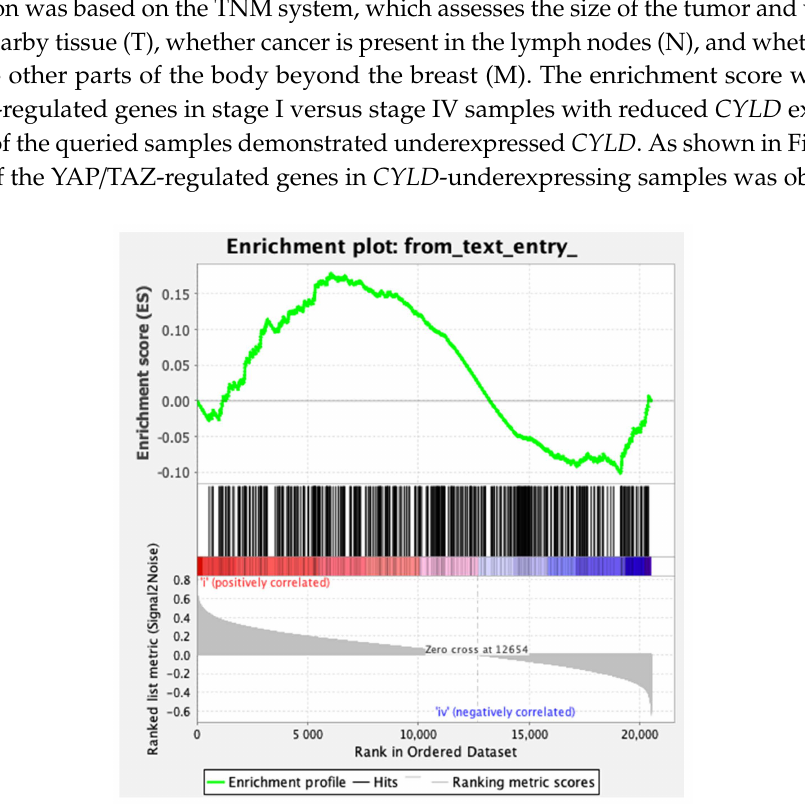
Figure 7. Gene set enrichment analysis (GSEA) of YAP / TAZ-regulated genes in relation to CYLD expression in breast cancer samples. Shown is the enrichment plot for the YAP / TAZ-regulated gene set correlated with reduced CYLD expression in stage I versus stage IV breast cancer cases. The enrichment score (ES) is